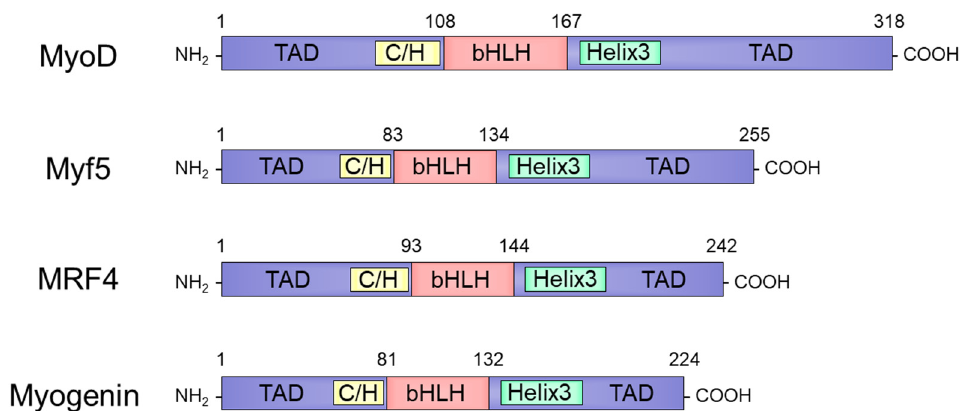
Figure 1. Protein structure of myogenic regulatory factors.